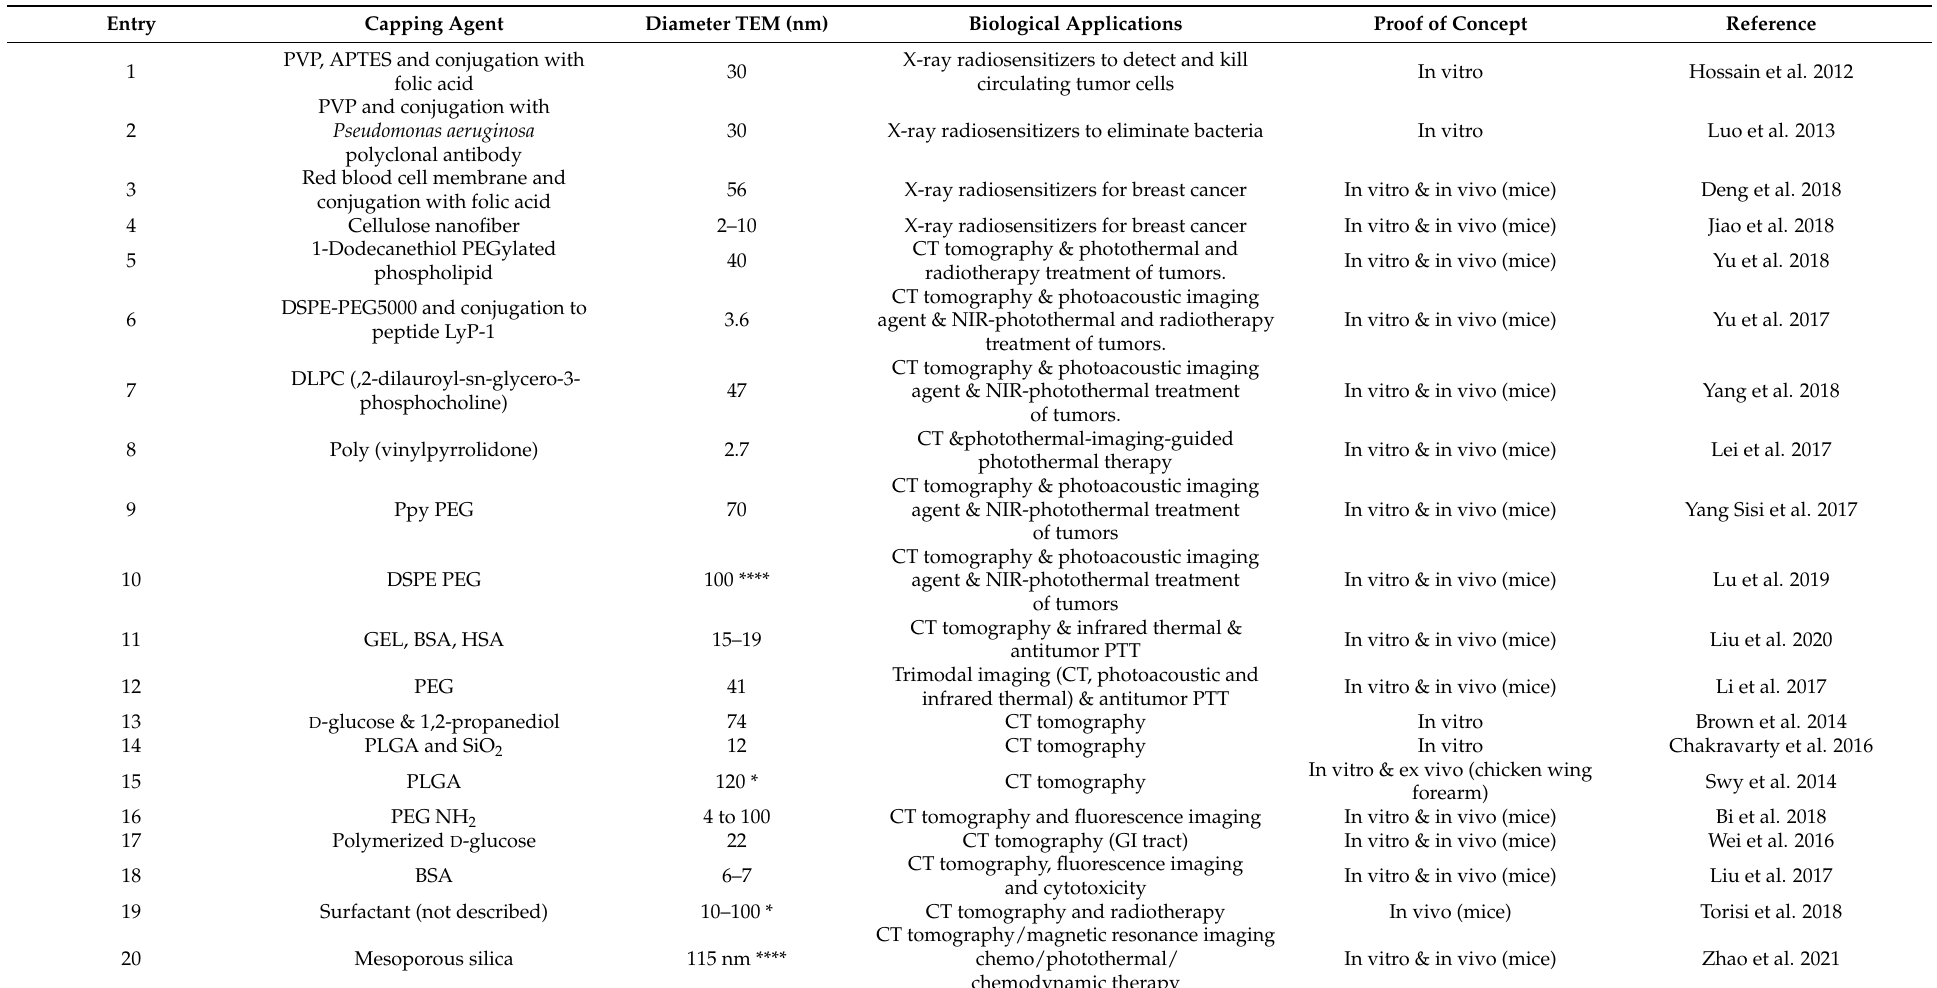
Table 1. Metallic bismuth nanoparticles as imaging contrast agents and as X-ray radiosensitizers, for theranostic